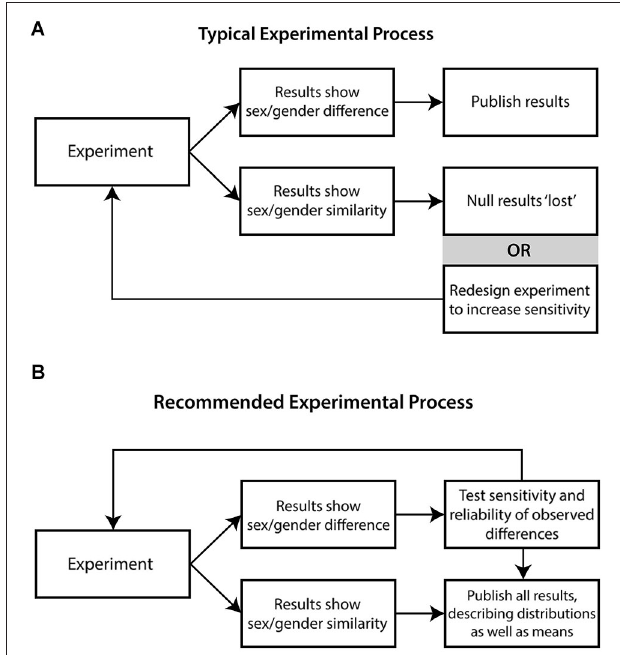
FIGURE 2 | Comparison of “typical” vs. “recommended” processes in NI research . (A) Typical experimental process in NI research on sex/gender is oriented towards identifying differences. Biological sex is considered primary; two sexes are routinely compared, and findings of “no difference” are often lost (though this may also stimulate redesign of study to better detect difference). (B) The recommended experimental process proceeds from the principle of overlap; when differences are observed, researchers attempt to discern the reliability and sensitivity of these observations to social and experimental context. Reports place equal emphasis on findings of sex/gender difference and similarity, with emphasis on